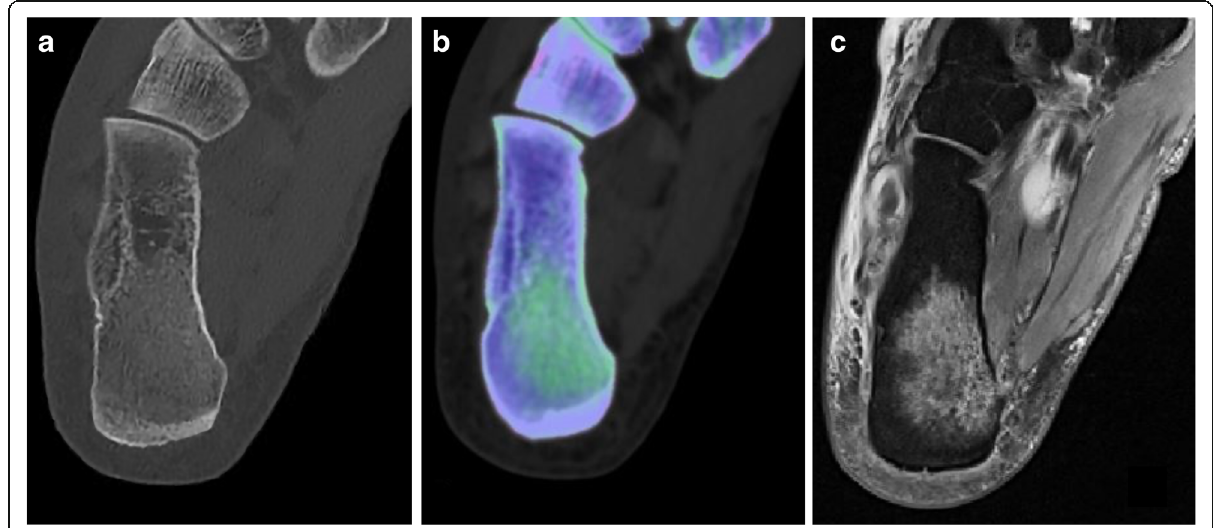
Fig. 5 Dual-energy computed tomography scan in a patient presenting with right-sided acute ankle trauma. Standard grayscale series ( a ) does not depict any fracture line. Color-coded virtual non-calcium image ( b ) shows a distinct traumatic bone marrow edema of the right calcaneus, displayed as a green area ( arrow ). The finding was confirmed by magnetic resonance imaging ( c ) using a proton density-weighted